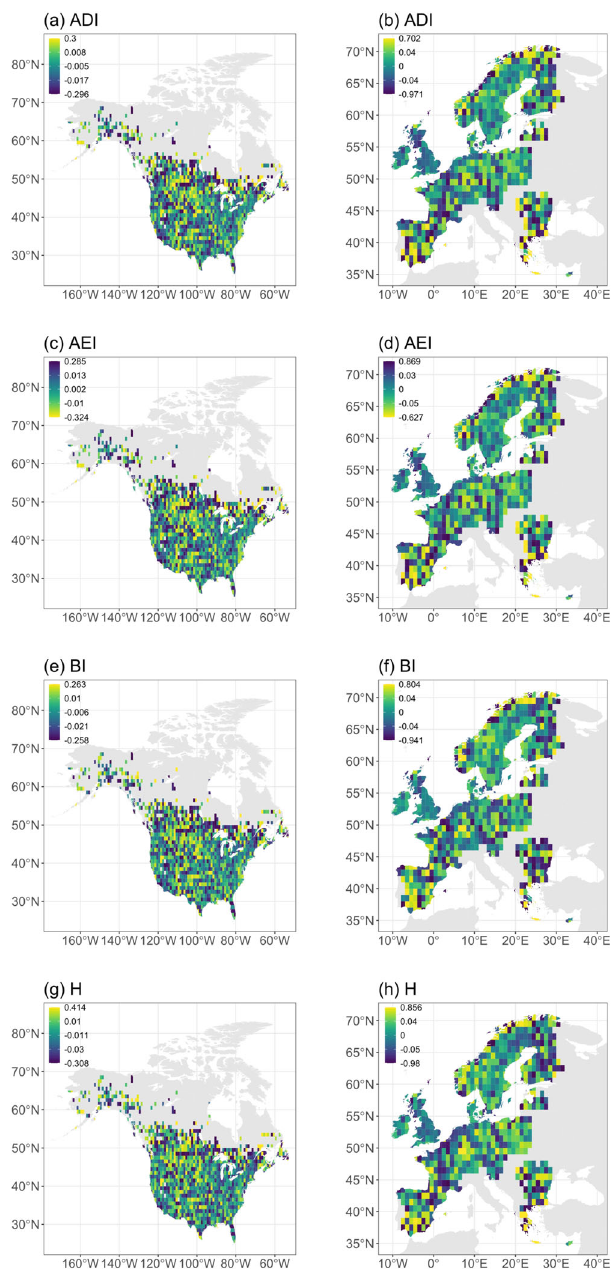
Fig. 4 Spatial variation in acoustic index trends. Mean site-level trend in Acoustic Diversity Index, ADI ( a , b ), Acoustic Evenness Index, AEI ( c , d ), Bioacoustic Index, BI ( e , f ) and Acoustic Entropy, H ( g , h ) in 1354 1°x1° grid squares across North America between 1996 and 2017 and 715 1°x1° grid squares across Europe between 1998 and 2018. Colours indicate the size and direction of trend in each acoustic index (yellow — improving soundscape quality; blue — declining soundscape quality); note that the colour scheme is reversed for AEI, as positive trends are taken to represent a reduction in soundscape quality for this index. Site-level trends are derived from changes in standardised annual values of each acoustic Europe : we used annual bird count data from 23 survey schemes across 22 countries collated under the Pan-European Common Bird Monitoring Scheme (PECBMS: https://pecbms.info) from 1998 to 2018. In each scheme, skilled volunteers carry out either line transects, point counts or territory mapping at survey sites during the breeding season and record all birds encountered 60 (Supplementary Table 5); while methods vary between survey schemes, they are consistent within schemes across the time period included here.